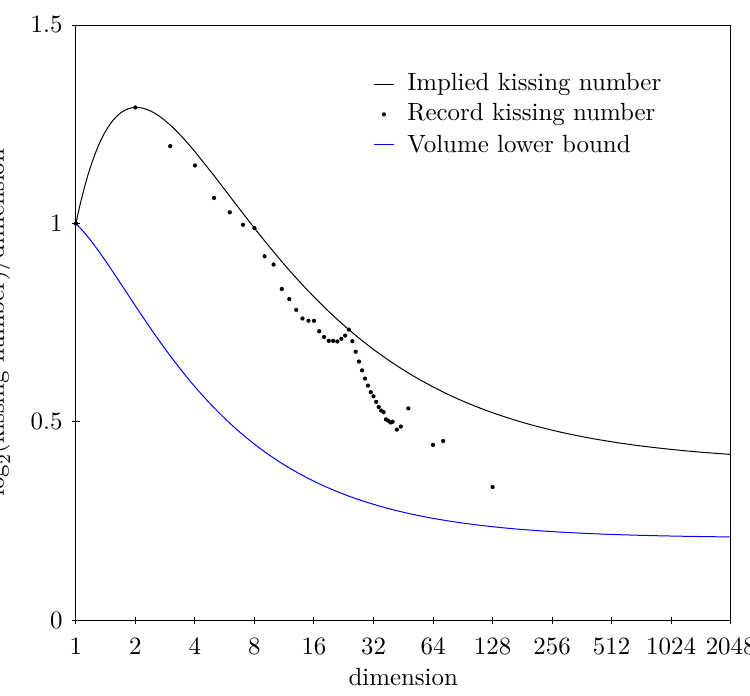
Figure 15 . The implied kissing number in high dimensions, compared with the record kissing number [21, 72] and the excluded volume lower bound for the kissing number from [73].